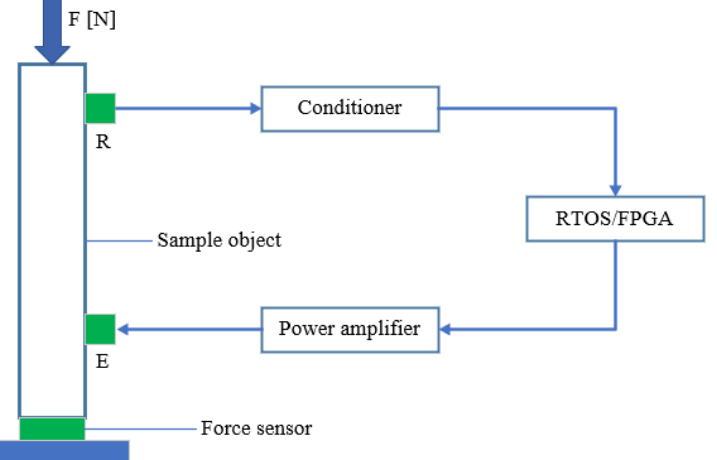
Figure 3. The scheme of the Self-excited Acoustical System: E—exciter; R—receiver; F—applied force.